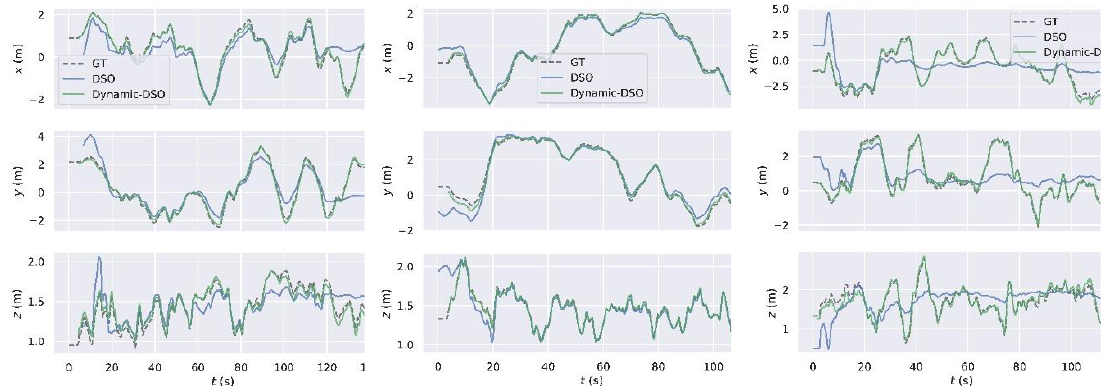
Figure 13. Positioning results comparison of DSO and Dynamic-DSO in three axes x, y, z. GT means the groundtruth. Comparison in V101_syn, V201_syn and V202_syn is shown from left to right.